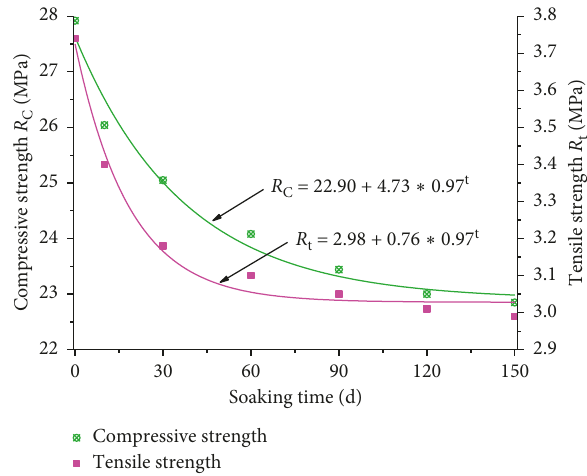
Figure 11: Degradation in the compressive and tensile strength of the specimens under long-term